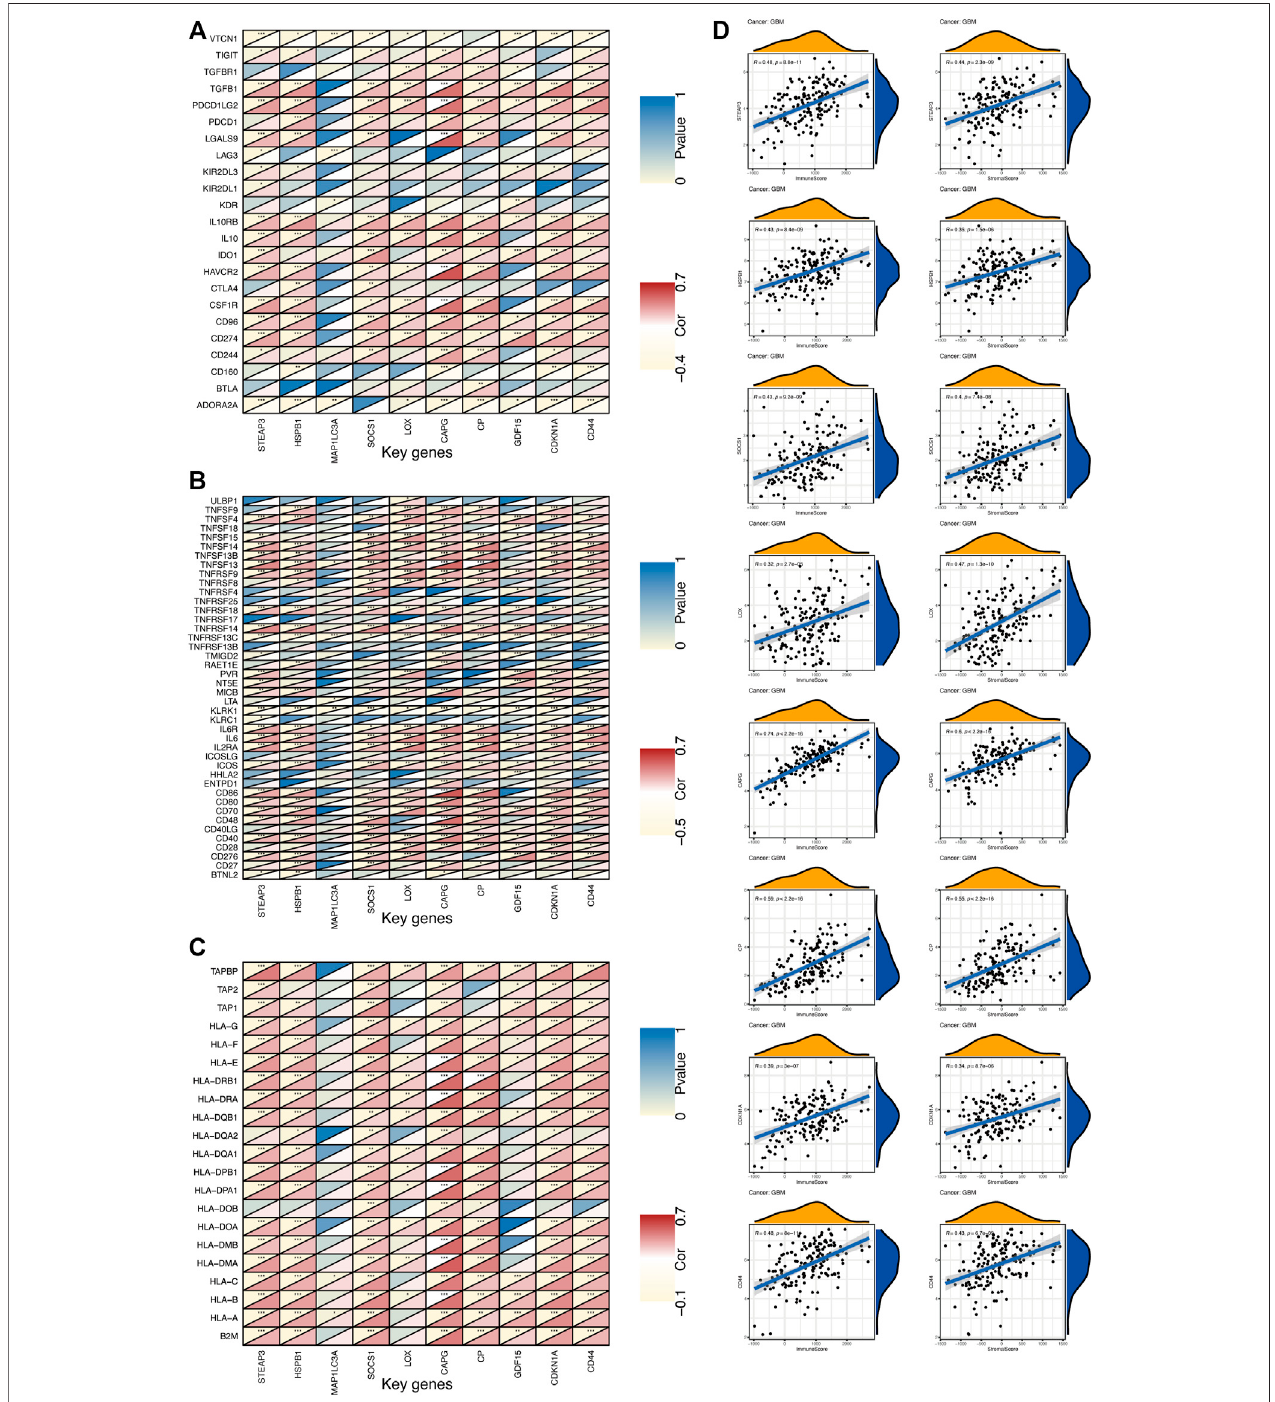
FIGURE 10 | The expression of key genes is correlated with GBM immunity (A) Heat map represents the correlation between immunoinhibitor and key gene expression in GBM. For each pair of genes, the triangles at the top left are colored to indicate the p values; the triangles at the bottom right are colored to indicate the Spearman correlation coef fi cients. * p < 0.05; ** p < 0.01; *** p < 0.001 (B) Heat map represents the correlation between immunostimulator and key gene expression in GBM (C) Heat map represents the correlation between MHC molecules and key gene expression in GBM (D) The correlation between key genes and ESTIMATE scores in